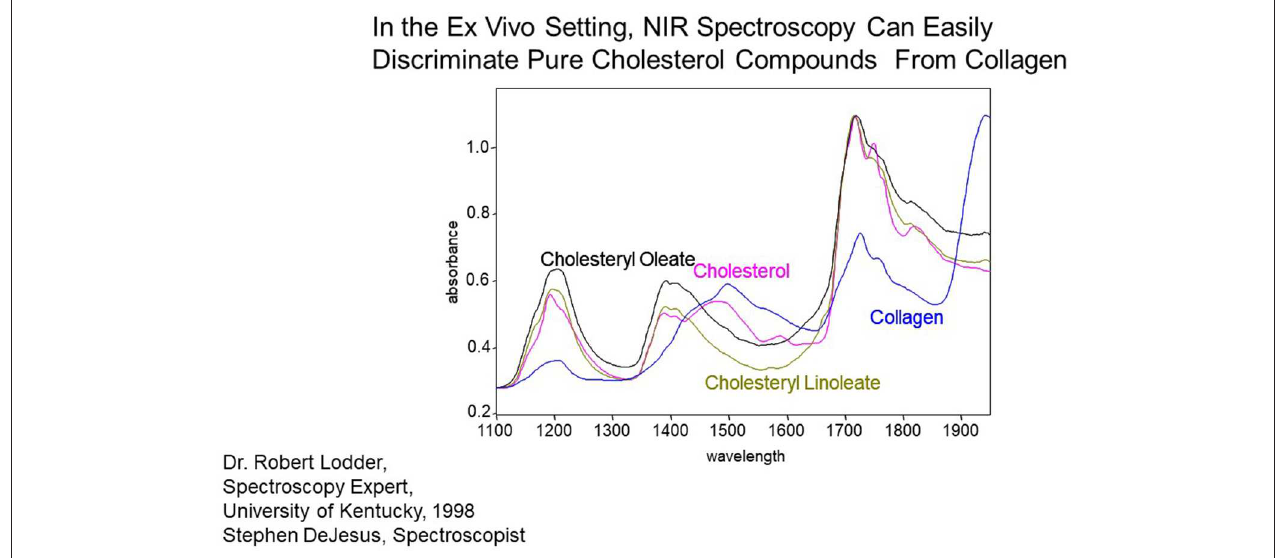
FIGURE 4 | Measurement of pure chemicals by spectroscopy in the absence of blood flow and motion. Substances of interest, such as collagen and cholesterol, are easily identified by their variable absorbance at different near-IR wavelengths.